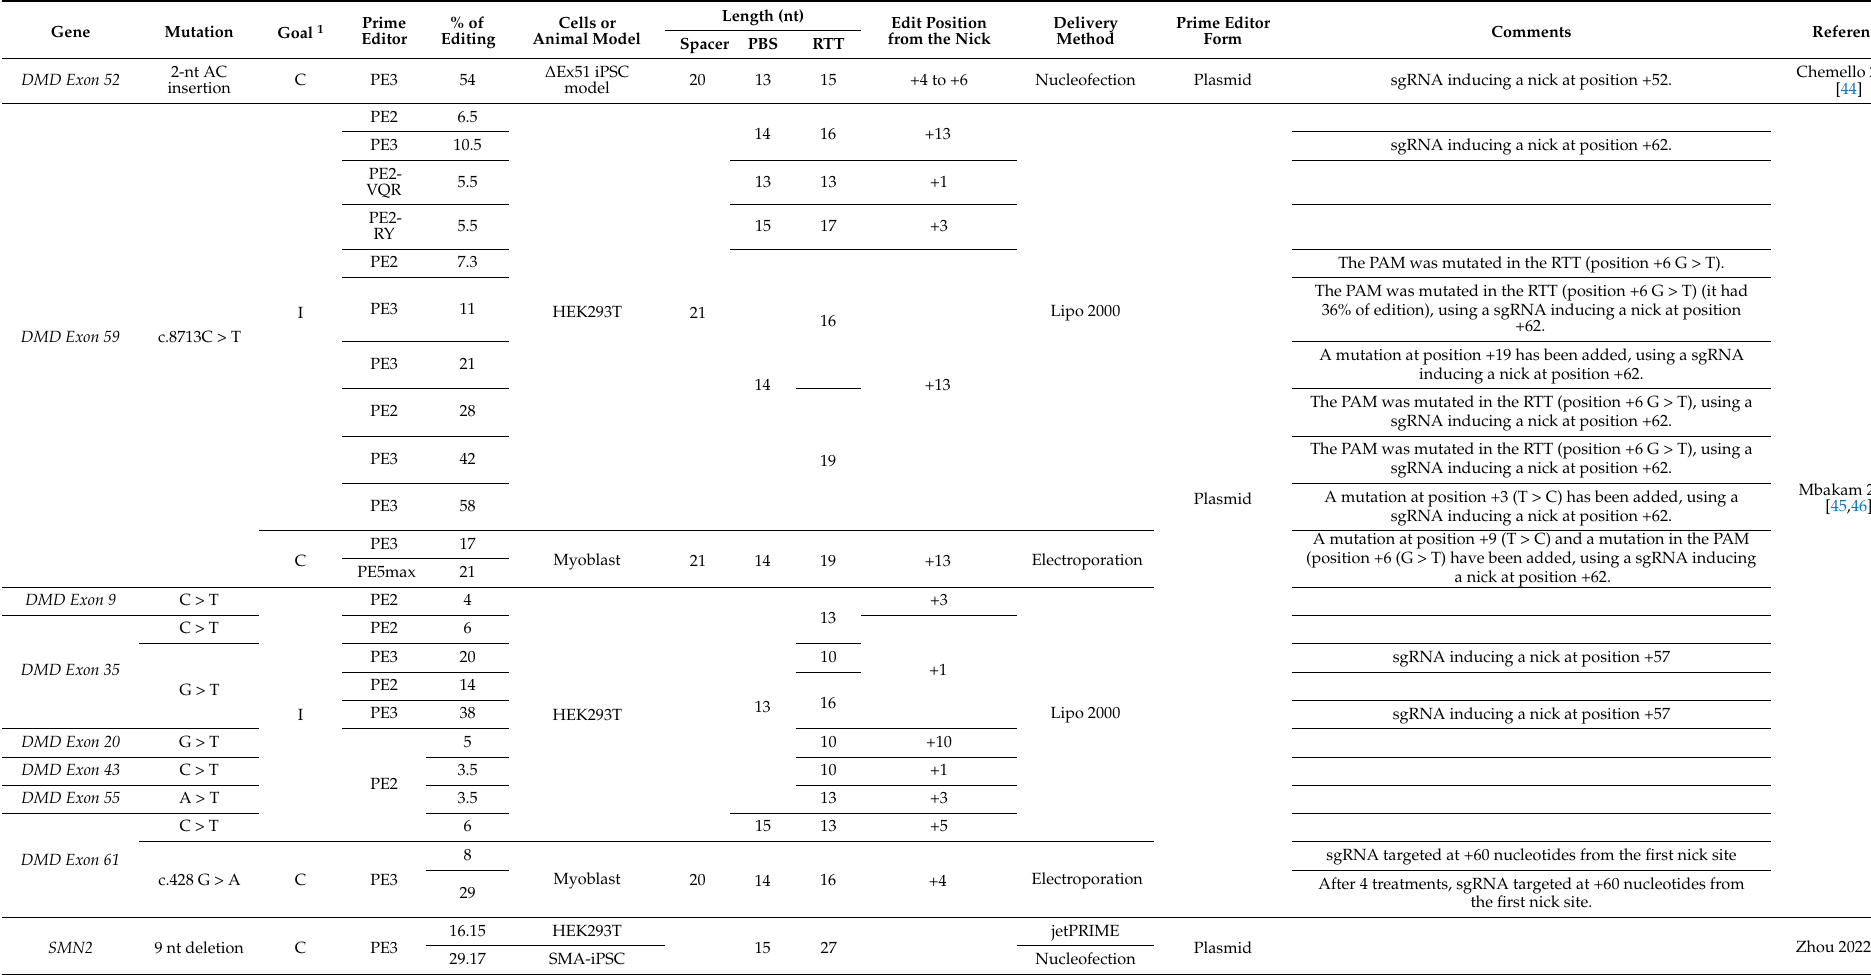
Table 5. Prime editing studies on correcting or introducing genetic mutations causing muscle and cardiac